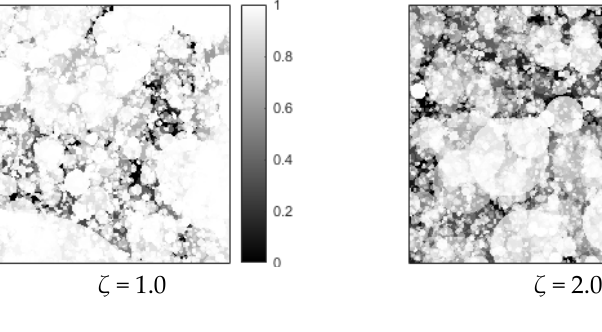
Figure 8. Multifractal porous materials synthesized by the compound Poisson cascades.